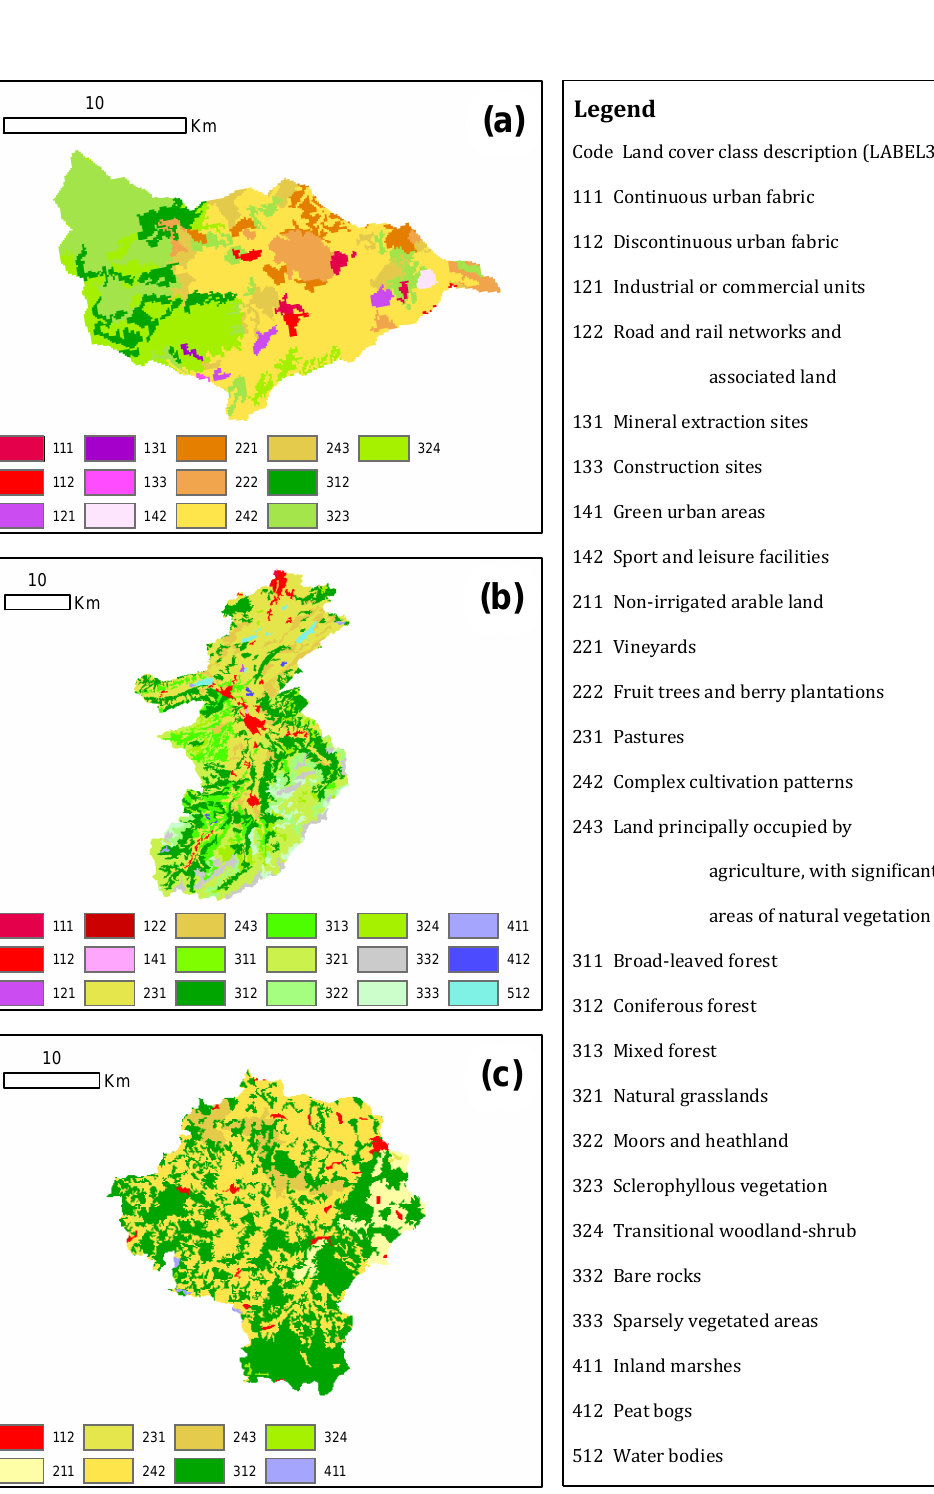
Fig. 4. CLC2000 classes (Source: European Environment Agency) obtained for the catchments: (a) Poyo, (b) Upper Iller and (c) Kamp. The direction of land cover changes for the afforestation scenarios are as follows: from codes 242 (complex cultivation patterns) at Poyo and Kamp and 231 (pastures) at Upper Iller to code 312 (coniferous